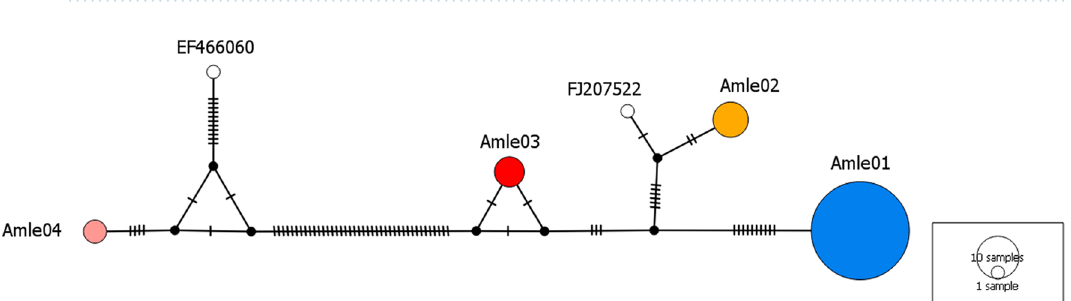
Figure 1. Sampling populations (labelled with a number) and geographic distribution of the four mitochondrial haplotypes identified within study of European aoudad populations. The pie charts indicate the relative frequency of the mtDNA haplotypes in each location: 1—Croatia, Mosor Mountain, 2—Czech, area near city of Plzeň, 3—Italy, Beigua Regional Park (marked with the star, since no haplotypes were revealed due to unsuccessful sequencing), 4—Spain, Sierra Espuña, 5—Spain, Almeria, 6—Spain, La Palma. Inserts show the location of La Palma off the northwestern coast of Africa ( A ), belonging to the archipelago of the Canary Islands ( B ). Map was generated with QGIS 2.18.26 software (QGIS.org, 2021. QGIS Geographic Information System. QGIS Association. http:// www. qgis. org).